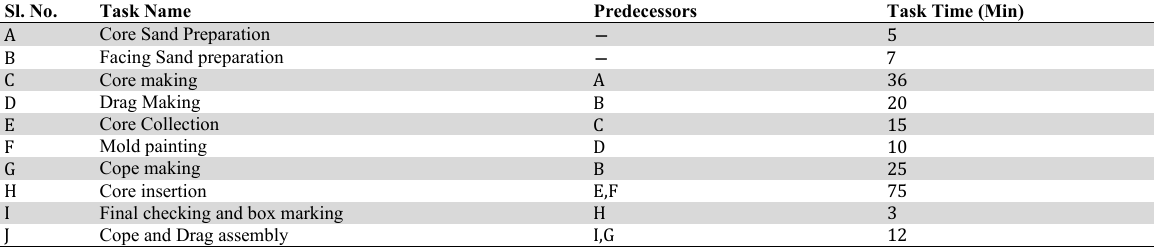
Task time before implementation of LMT Sl. No.